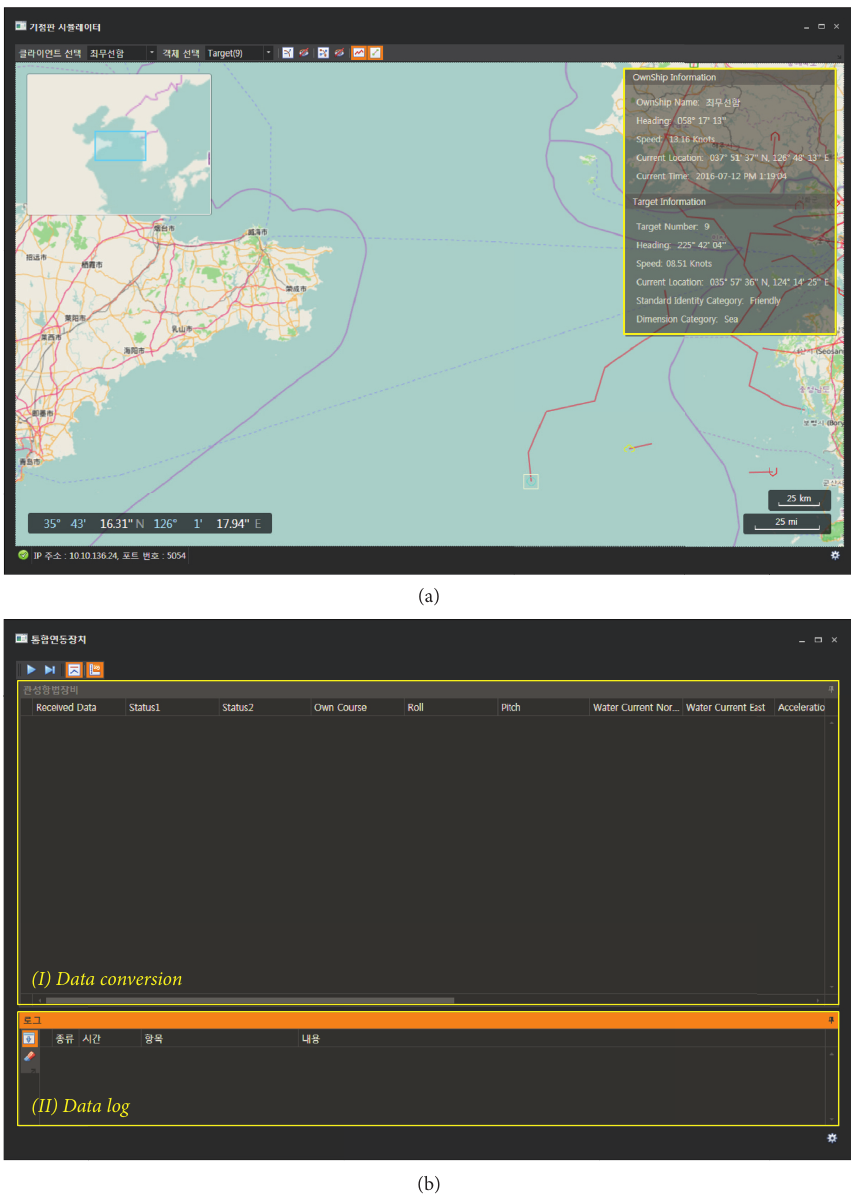
Figure 10: GUIs of the developed simulators: (a) plotting board simulator; (b) DIS